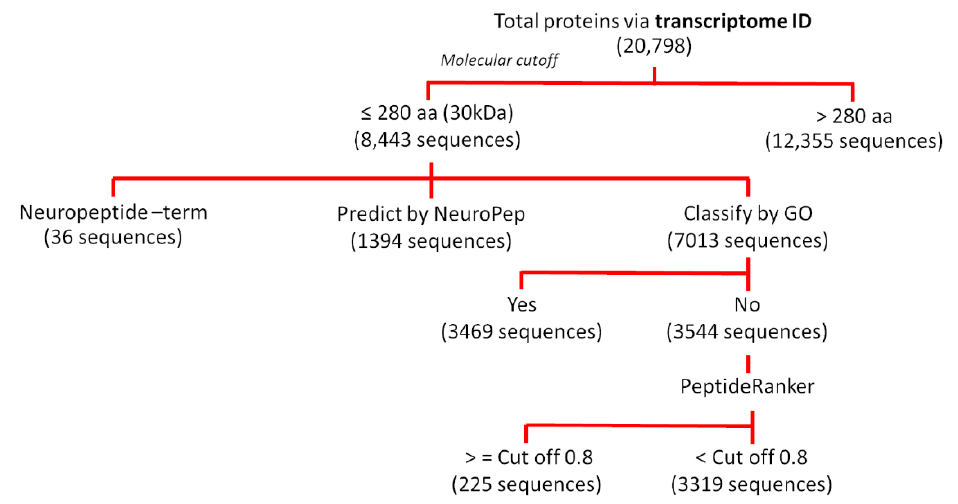
Figure 1. In silico transcriptome mining workflow for S. mekongi peptidome prediction.